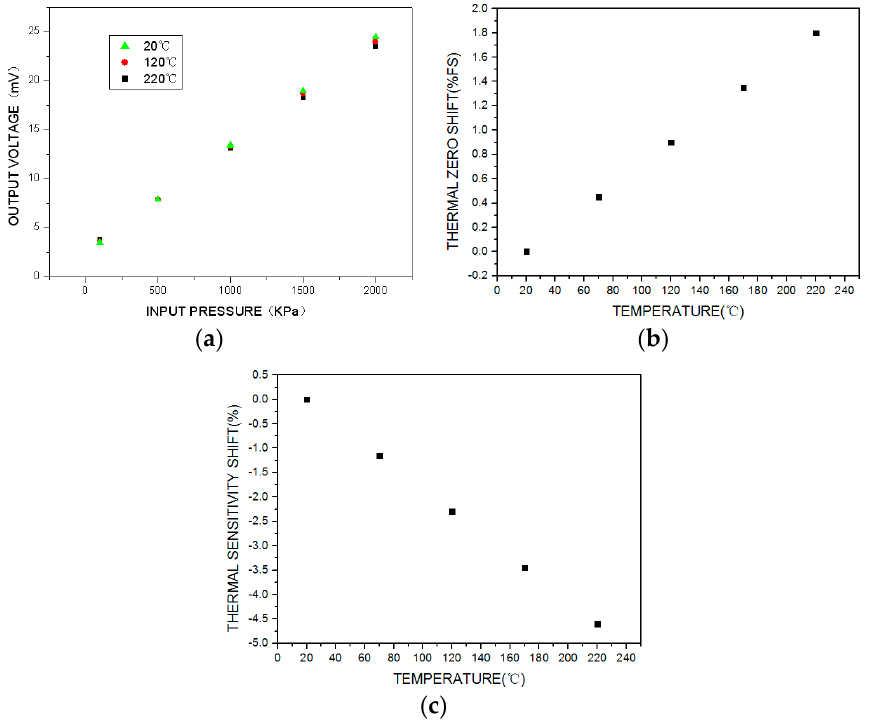
Figure 12. Test results for the compensated high-temperature pressure sensor with the passive resistor temperature compensation model and experiential arithmetic: ( a ) output voltage calibration curve in the temperature and pressure environment; ( b ) thermal zero shift; ( c ) thermal sensitivity shift.